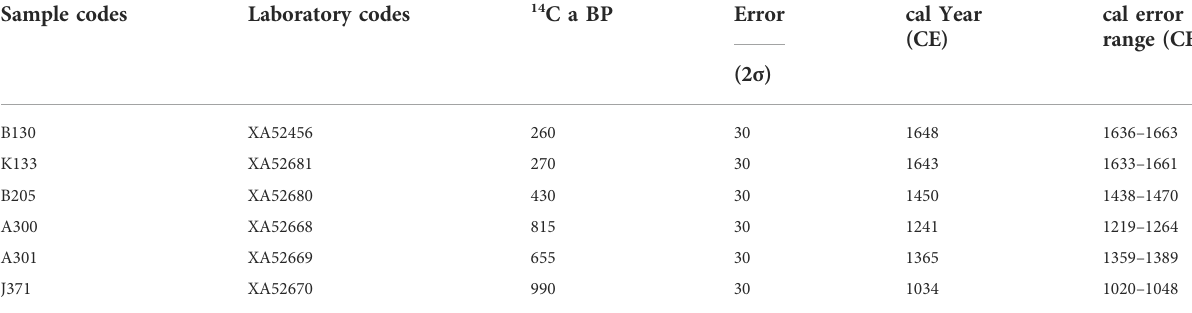
TABLE 2 AMS 14 C dating of plant residues (the calendar year correction mode is